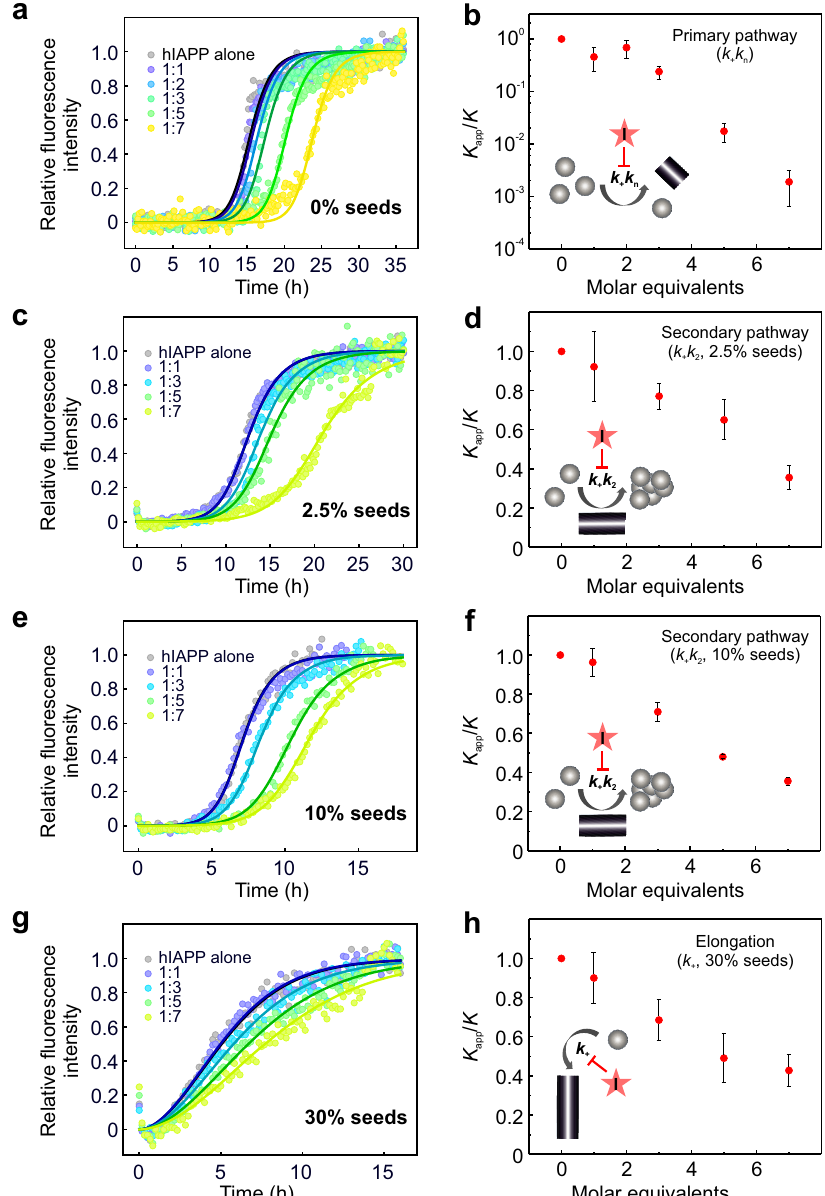
Fig. 5 YX-I-1 inhibits primary nucleation, secondary nucleation and elongation of wt hIAPP. Aggregation kinetics of 10 μ M wt hIAPP in the absence or presence of a 1:1, 1:2, 1:3, 1:5 or 1:7 molar ratio of wt hIAPP:YX-I-1 are shown in the presence of different amounts of preformed fi bril seeds. In each plot the solid lines show predications from global fi tting of the experimental data as indicated. a Aggregation kinetics in the absence of fi bril seeds with different molar ratios of hIAPP:YX-I-1, as indicated. The solid lines show fi ts in which the combined rate constant for primary nucleation and elongation ( k + k n ) was varied. b Changes in k + k n in the presence of increasing concentrations of YX-I-1 relative to the rate constants of aggregation reaction treated with DMSO alone. K is the combined rate constant k + k n in the presence of DMSO; K app is the combined rate constant k + k n in the presence of YX-I-1. Aggregation kinetics in the presence of 2.5% (v/v) ( c ) or 10% (v/v) ( e ) preformed fi bril seeds with different molar ratios of hIAPP:YX-I-1, as indicated. The solid lines show fi ts in which the combined rate constant for secondary nucleation and elongation ( k + k 2 ) was varied. d , f Changes in k + k 2 in the presence of increasing concentrations of YX-I-1 relative to the rate constants of aggregation reaction treated with DMSO alone. K is the combined rate constant k + k 2 in the presence of DMSO; K app is the combined rate constant k + k 2 in the presence of YX-I-1. g Aggregation kinetics in the presence of 30% (v/v) preformed fi bril seeds with different molar ratios of hIAPP:YX-I-1, as indicated. The solid lines show fi ts in which only the elongation rate constant ( k + ) was varied. h Changes in k + in the presence of increasing concentrations of YX-I-1 relative to the rate constant of aggregation reaction treated with DMSO alone. K is the elongation rate constant k + in the presence of DMSO; K app is the elongation rate constant k + in the presence of YX-I-1. All the experiments were performed in 25 mM sodium phosphate, pH 6.8 at 30 °C, quiescently. Results are mean ± SD of n = 3.